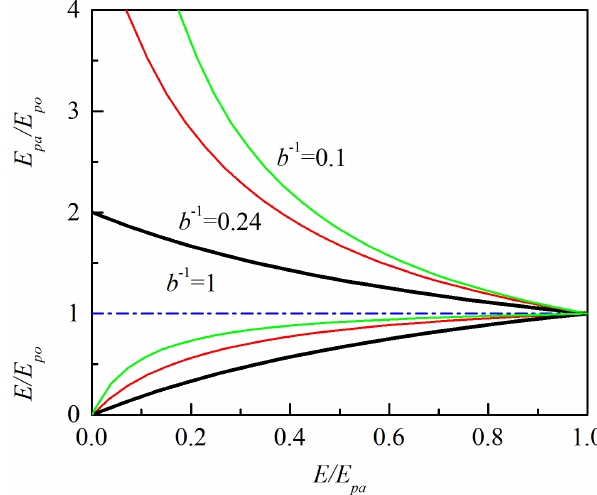
Figure 2. Scaled E p and E , which serve as functions of the a evaporative moisture index E/E p and are calculated on the basis a of the asymmetric CR, according to method of Kahler and Brut- saert